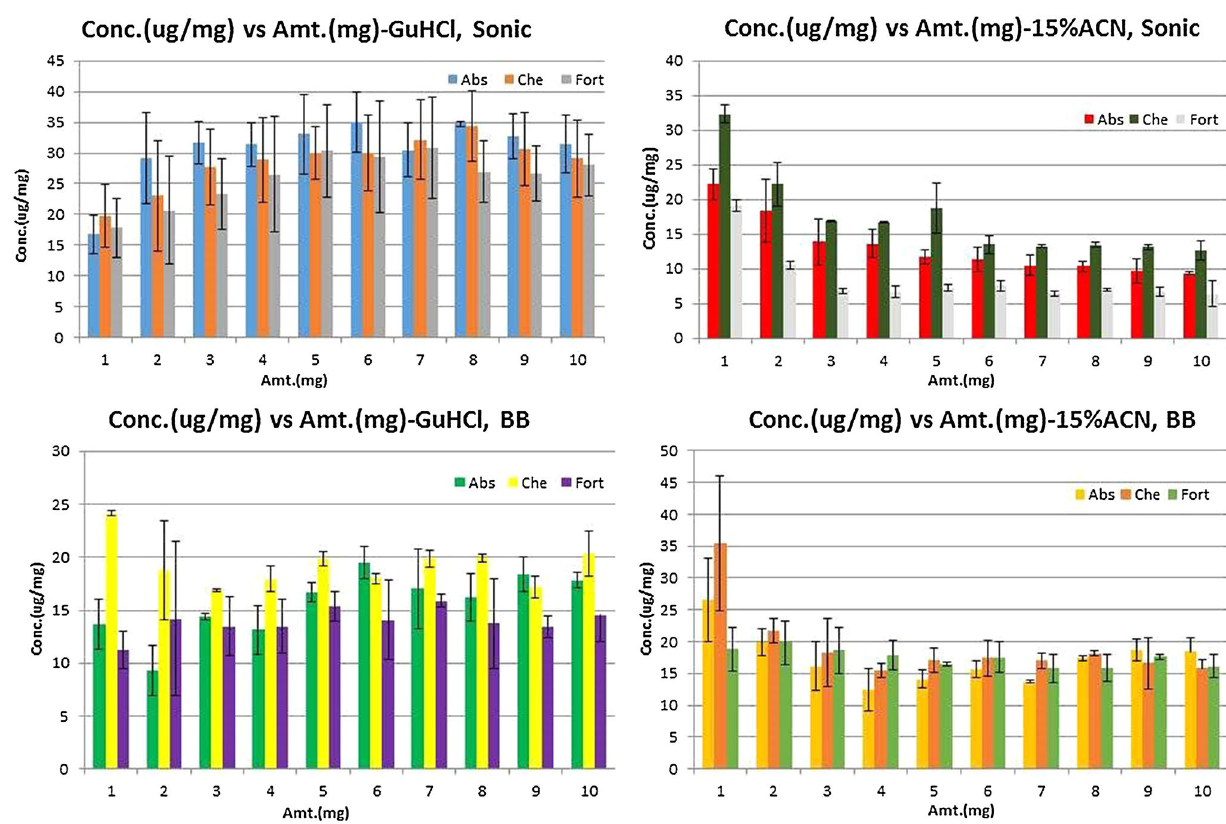
Fig. 1 (Color). Plot of amount of proteins extract (µg/mg) vs amount (wet weight, mg) of cell used for lysis for sonication and bead beating (BB) lysis method with two extraction solvents. Abs = M. abscessus , Che = M. chelonae , Fort = M. fortuitum